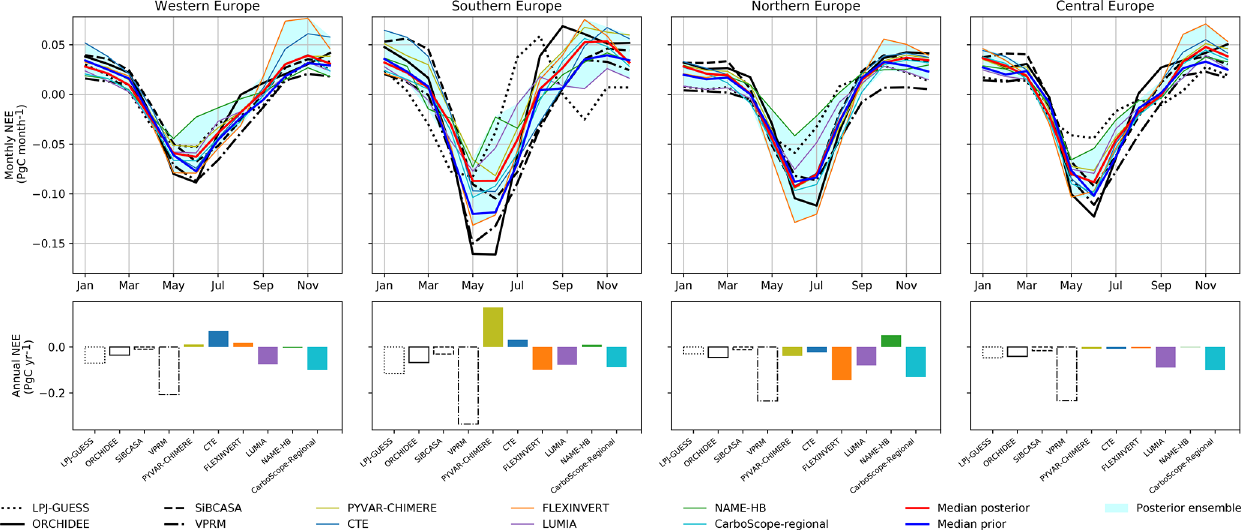
Figure 9. Upper row: mean prior (black lines) and posterior (coloured lines) seasonal cycle of the terrestrial carbon flux in the four regions highlighted in Fig. 1; prior and posterior ensemble median (thick blue and red lines) and posterior spread (blue shaded area). Lower row: mean annual net terrestrial carbon flux for these same